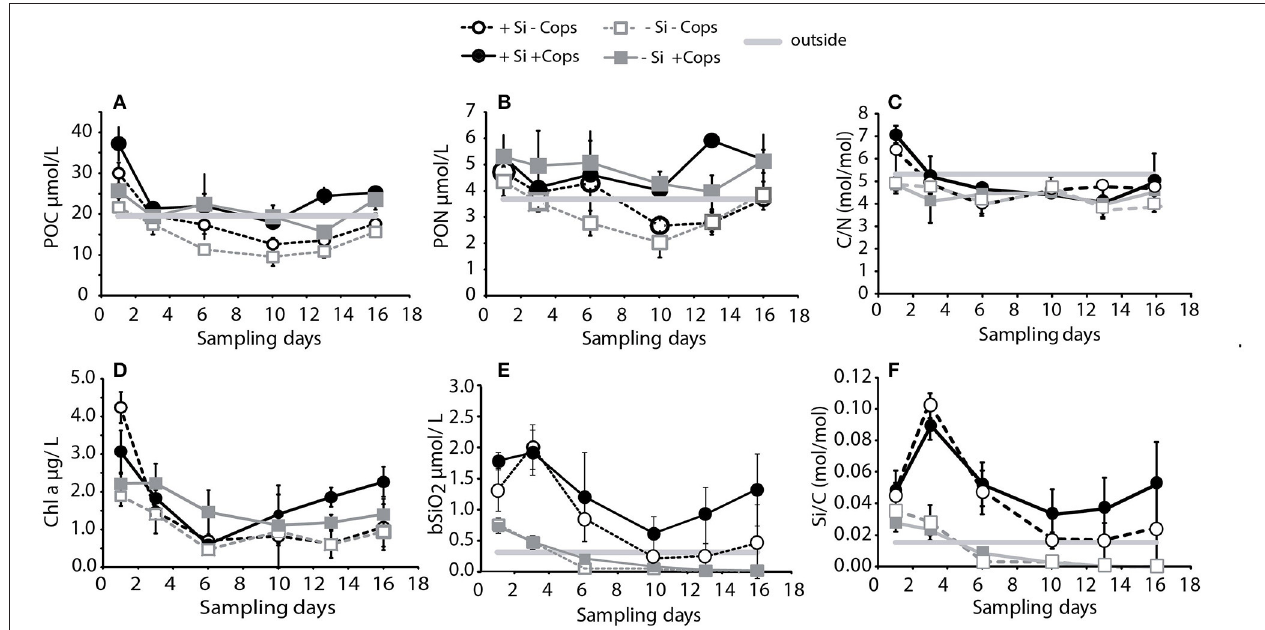
FIGURE 5 | Composition of standing stocks of biomass in the upper 4.5m of the four treatments: (A) POC, (B) PON, (C) C/N, (D) chlorophyll a, (E) bSiO2, and (F) Si/C. Data points and error bars represent averages and standard deviations for the three mesocosms of each treatment. Gray lines represent concentrations in the Bay outside mesocosms as measured at the end of the experiment (Day